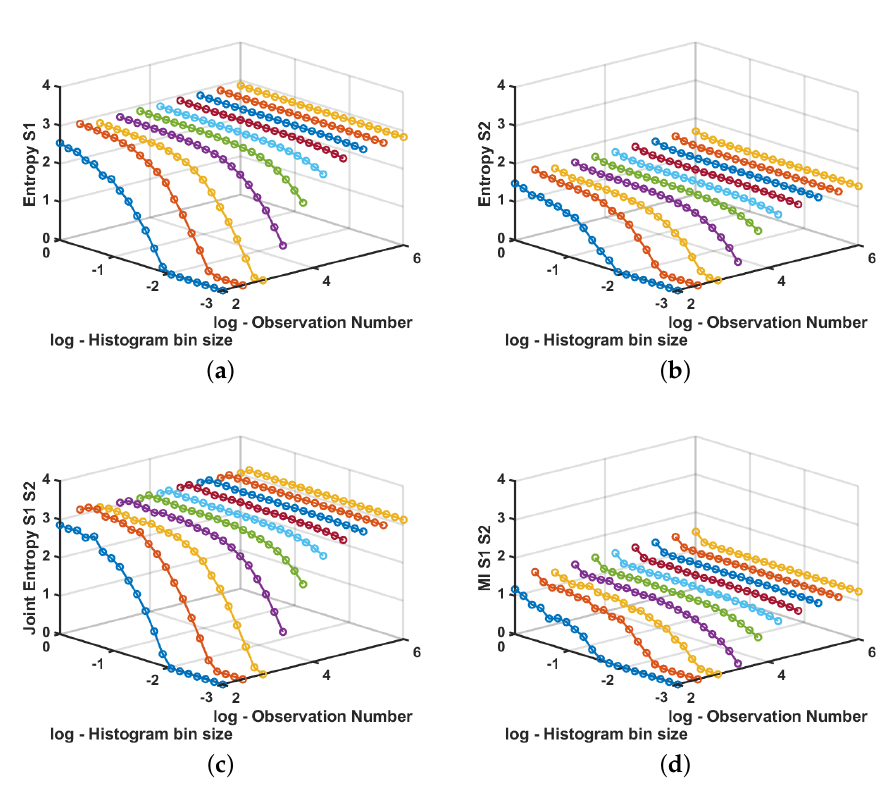
Figure 6. Example of entropy, joint entropy, and MI estimation in synthetic data signals. ( a ) Estimated entropy for the first random process. ( b ) Estimated entropy for the second random process. ( c ) Estimated joint entropy between both processes. ( d ) Estimated MI for the presented